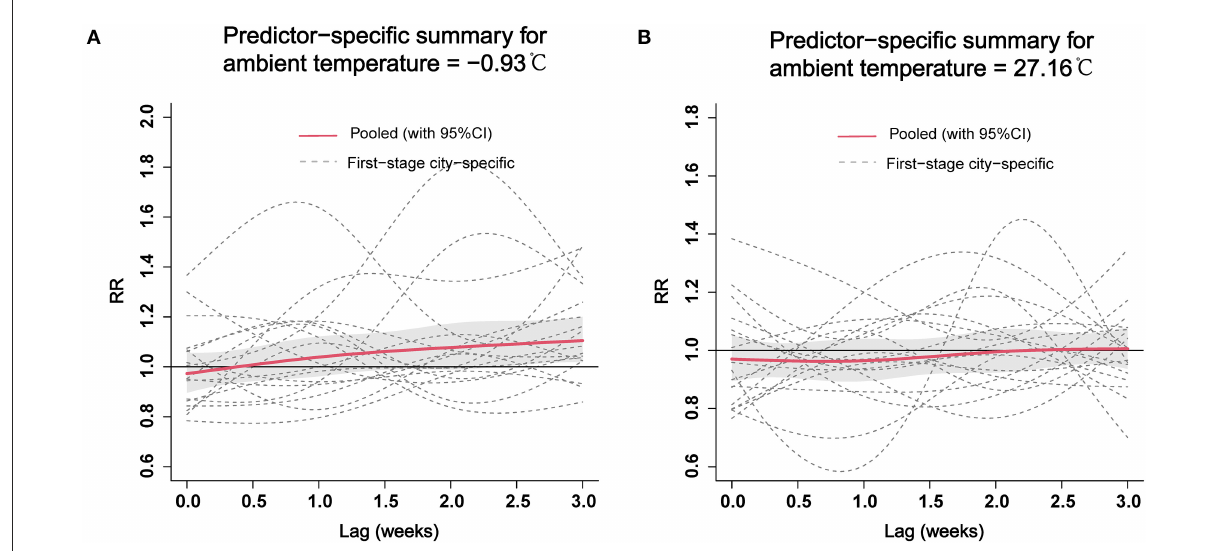
FIGURE5 The pooled estimates of specific lag–response curves of cold effect (A) and hot effect (B) on ILI at the provincial level. ILI, influenza-like-illness; RR, relative